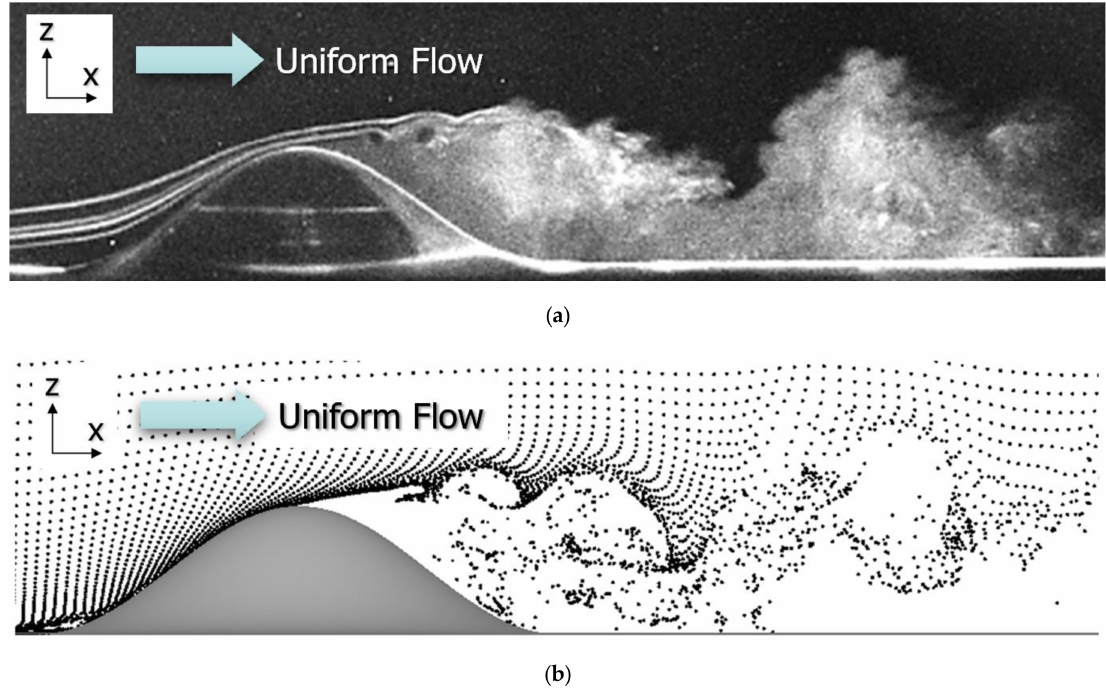
Figure 4. Comparison of flow patterns past a three-dimensional isolated steep hill at a Reynolds number (Re) of 10 under neutral conditions. ( a ) Wind tunnel experiment using the smoke-wire technique; ( b ) Large eddy simulation using the passive particle tracking